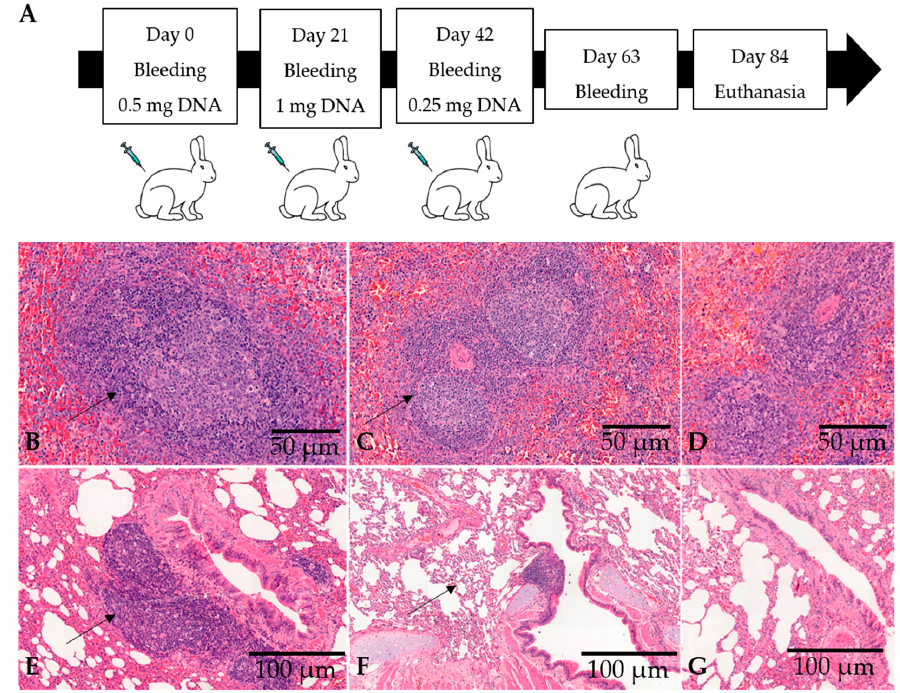
Figure 2. Rabbit RBD and spike DNA-based immunization. ( A ) Rabbit immunization schedule. ( B – G ) Histopathology of spleen and lungs. The immunized rabbits showed lymphoid hyperplasia